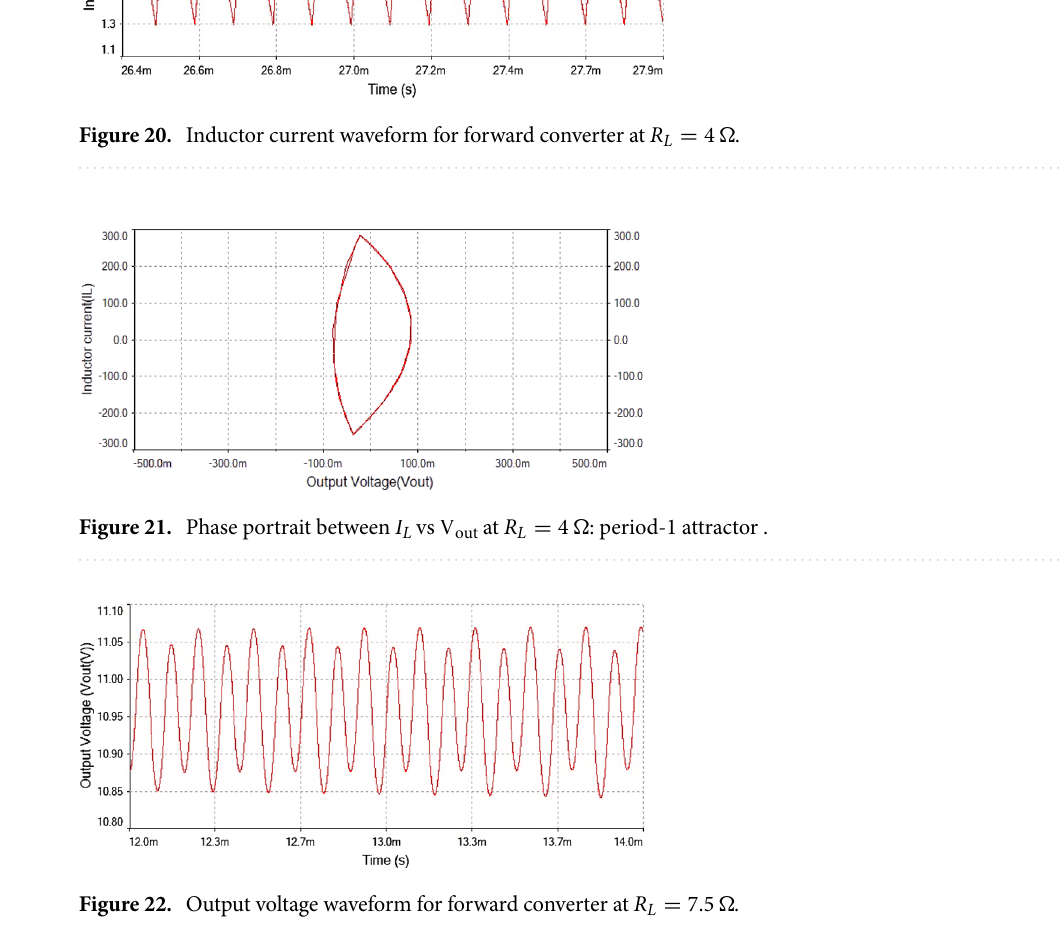
portrait plot between inductor current and output voltage also indicated the converter had period-2 at R L = 7.5 (cid:31) which is shown in Fig. 24. In Figs. 22 and 23 for R L = 7.5 (cid:31) the inductor current ( I L ) and output voltage ( V out ) were shown. It had been observed from the time series waveform that it has period-2. The phase portrait plot had also conformed period doubling phenomenon was shown in Fig. 24.